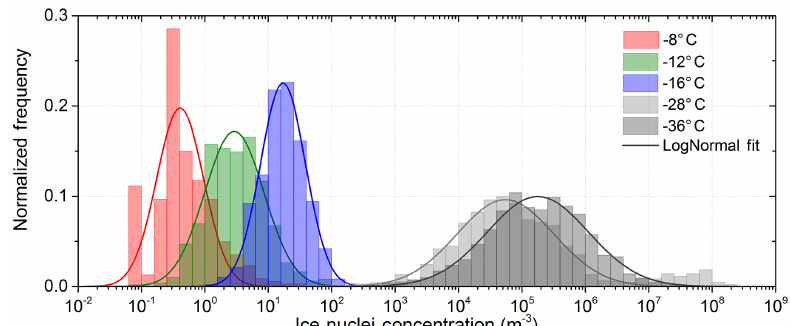
Figure 5. Frequency distribution of measured IN concentration with lognormal fit